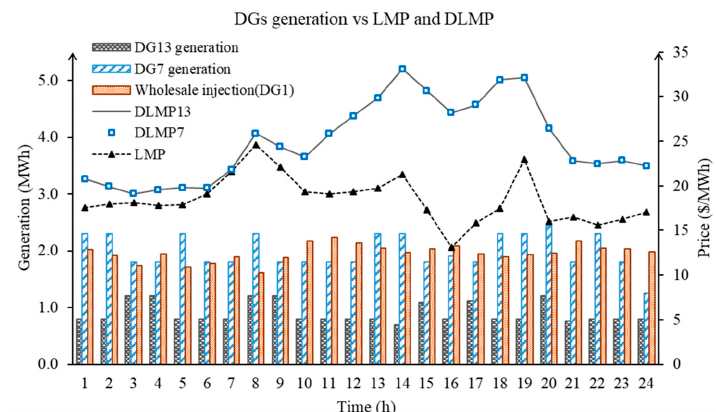
Figure 6. Wholesale injection at LMP versus DG7 and DG13’s schedules and